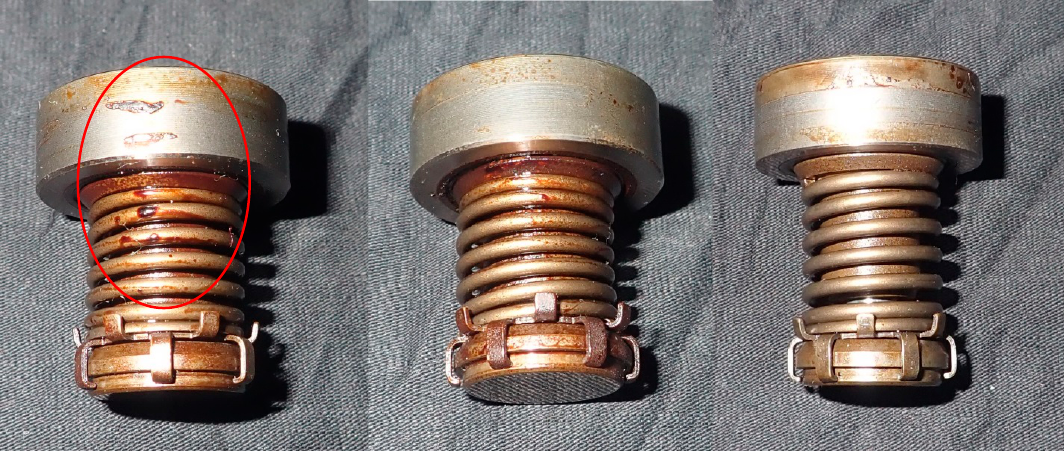
Figure 14. Pumping elements of the CP1S pump cylinders (barrel, plunger, spring). Two out of the three elements were stuck in the Top Dead Center position (end of delivery